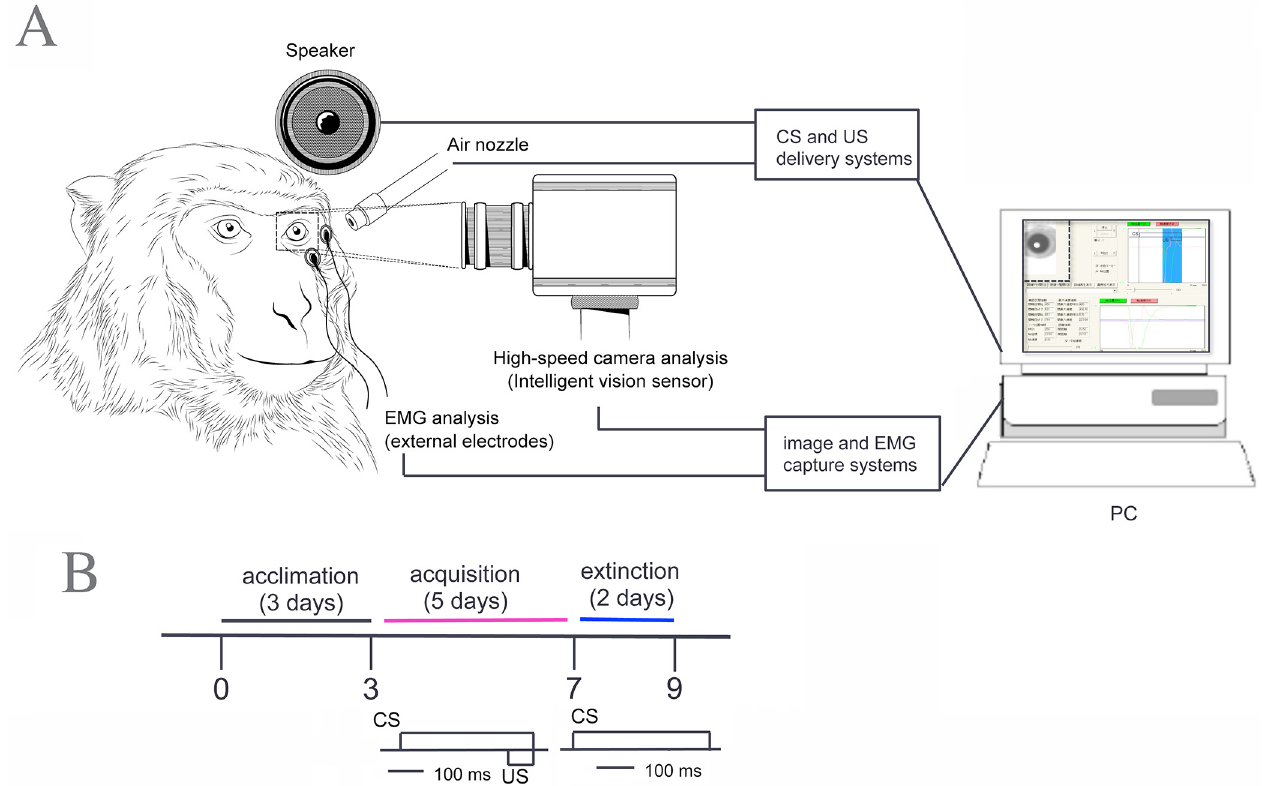
Fig 1. Schematic diagram of the system for evaluating eyeblink conditioning in monkeys. (A) The multi-measuring system for detecting delay eyeblink conditioned responses (CRs) in monkeys is illustrated. The system consists of PC-based software and hardware that control the experiment by activating the conditioned stimulus (CS) and unconditioned stimulus (US) delivery systems and that acquire electromyographic (EMG) and video data from skin electrodes and a digital camera, respectively. A monkey is shown restrained as it appears during eyeblink conditioning. The eyeblink behavior of the monkey is simultaneously measured and detected by EMG and video. During conditioning, a 1-kHz tone from a speaker close to the left ear provides the CS. The US is an air-puff delivered from a nozzle to the left cornea. EMG signals are picked up from the left temple, and the movement of the left eyelid (ipsilateral to the air- puff stimulation) is measured by the Intelligent Vision Sensor. Inset upper right : the temporal relationship between the CS and US in the delay eyeblink conditioning paradigm. (B) The experimental design for delay eyeblink conditioning in monkeys. The moment of the CS and US presentations is shown under the timeline for behavioral test. See Materials and Methods for